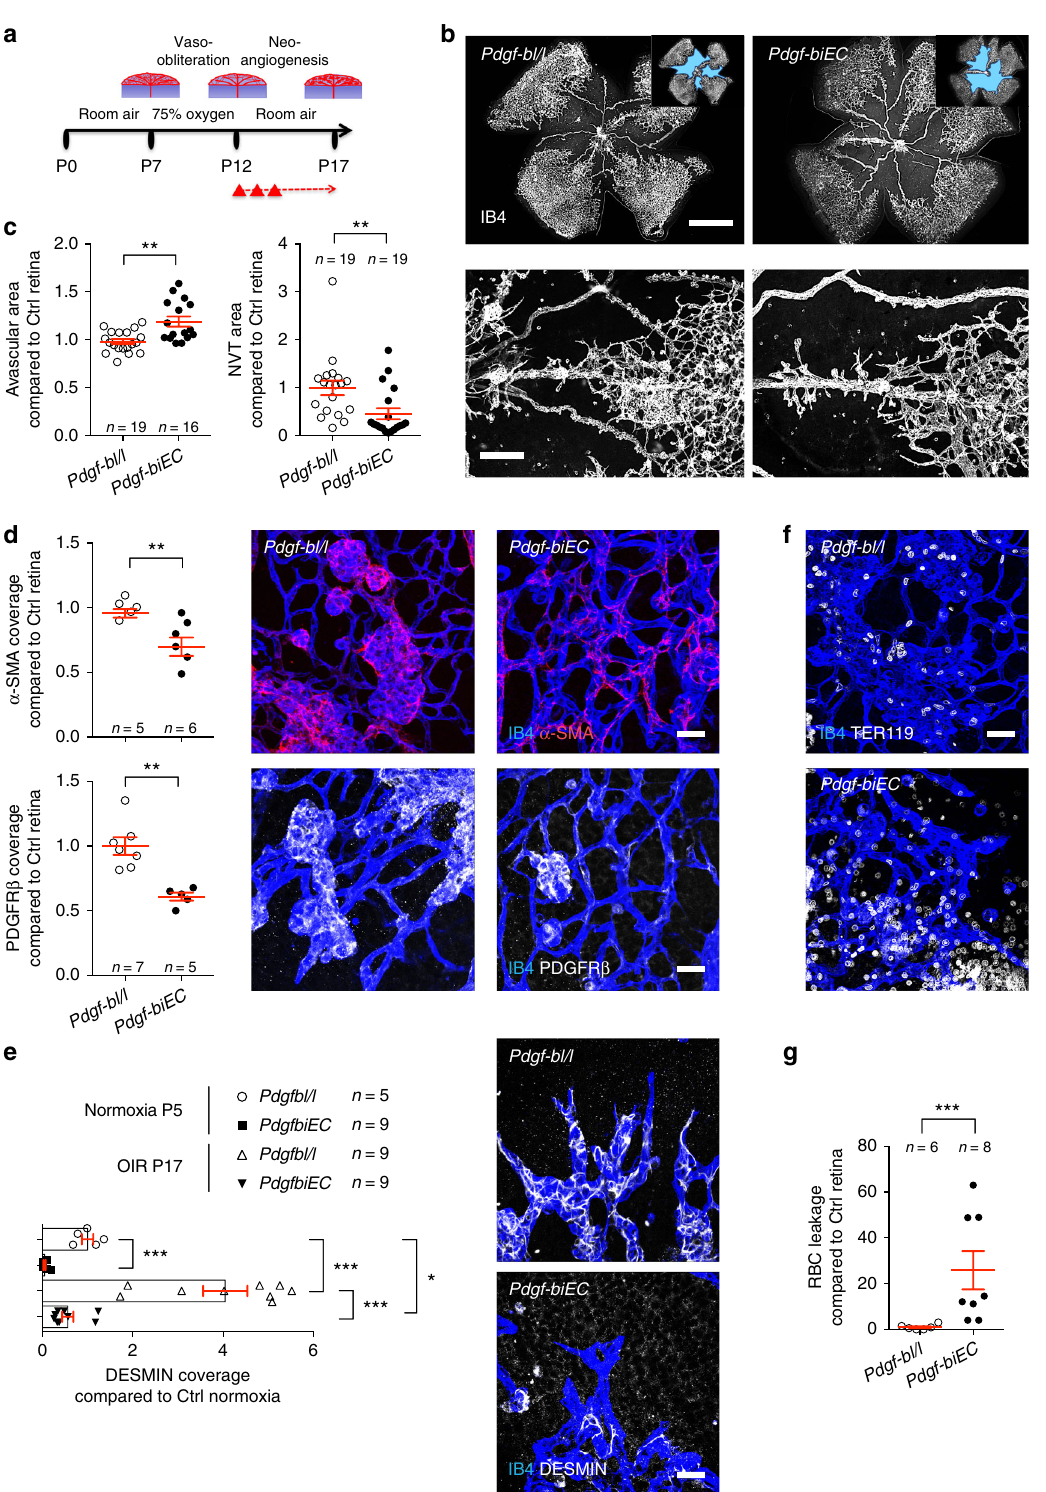
pathological angiogenesis, we induced ischemic retinopathy in Nck1 − / − Nck2iMC mice. Induction of Nck2 deletion was done after exposure to hyperoxia, during the neovascularization period (P12 – P17; Fig. 8a). As expected, the P12 avascular area was similar between Nck1 − / − Nck2l/l control littermates and Nck1 − / − Nck2iMC mice (Supplementary Fig. 10c). After Nck2 dele- tion at P12 – P17, the Nck1 − / − Nck2iMC mice showed reduced NVT formation, whereas revascularization into the vaso-